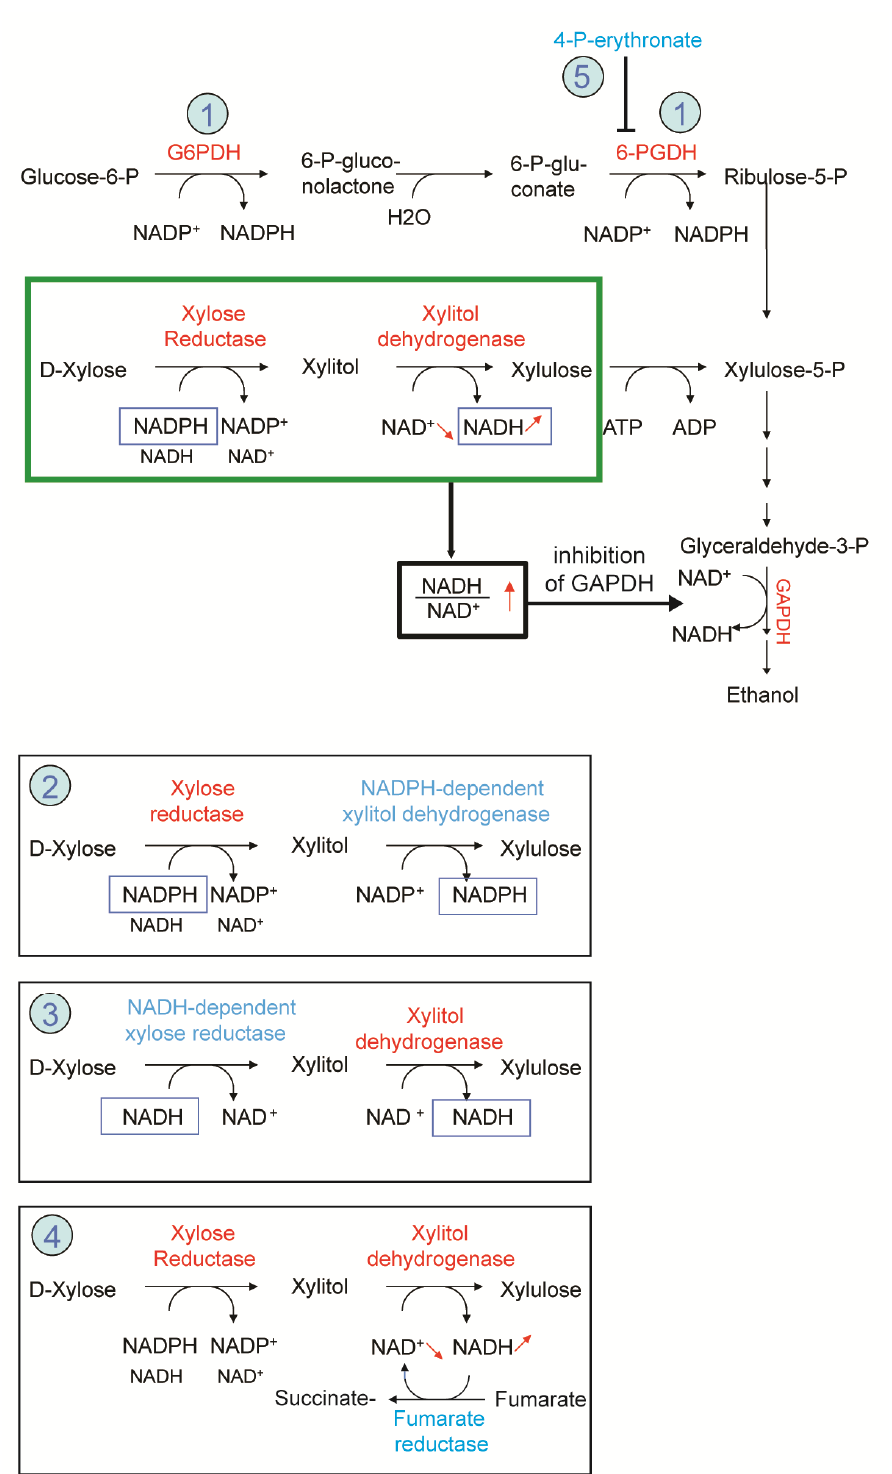
FIGURE 2: Inhibition of the pentose phosphate pathway prevents nicotinamide nucleotide imbalance and facilitates production of ethanol from xylose. Preferential usage of NADPH by xylose reductase and NAD + by xylitol dehydrogenase leads to an increase in cellular NADH/NAD + ratio which limits glyceraldehyde 3-phosphate dehydrogenase (GAPDH) activity (green box). This can be alleviated (highlighted in blue) by (1) reducing NADPH production in the oxidative pentose phosphate pathway by deleting the enzymes glucose-6-phosphate dehydrogenase (G6PDH) or 6- phosphogluconate dehydrogenase (6-PGDH), (2) by expression of a NADP-dependent xylitol dehydrogenase, (3) by expression of a NADH-dependent xylose reductase, (4) expression of NADH-consuming fumarate reductase or (5) by inactivation of PGP, which leads to the accumulation of 4-P- erythronate leading to an inhibition of 6-PGDH in the pentose phosphate